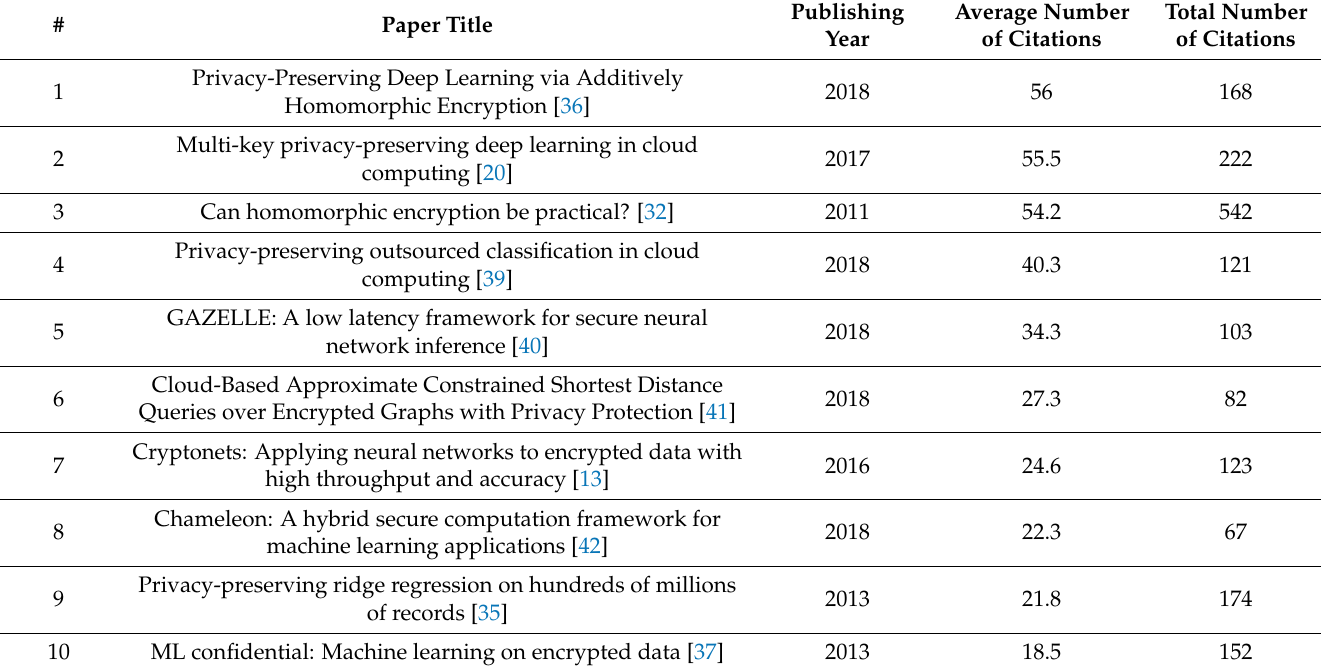
Table 5. Top 10 papers with average annual citations since